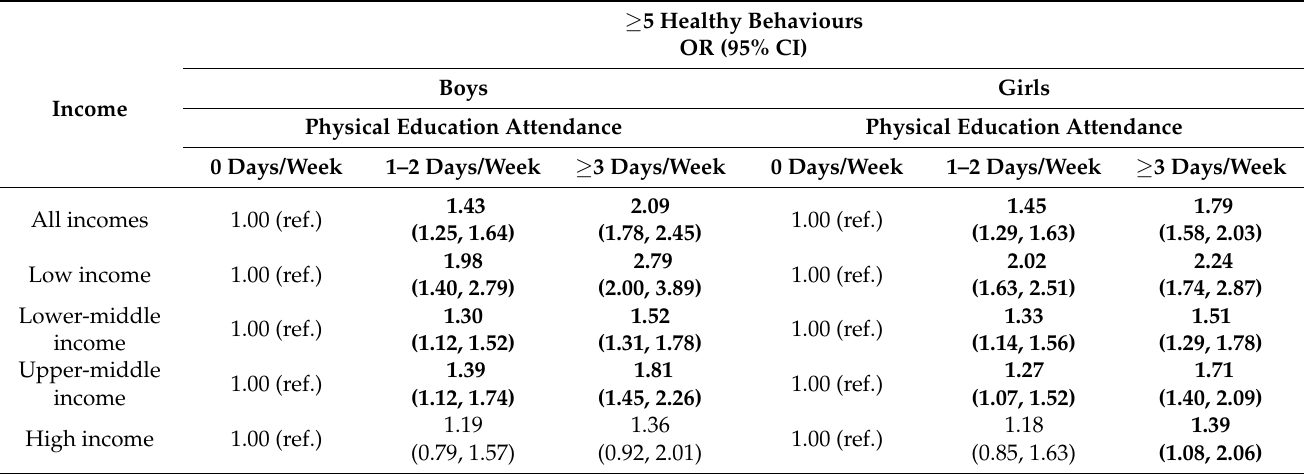
Table 5. Relationship between ≥ 5 healthy behaviours and PE participation, stratified by income (World Bank